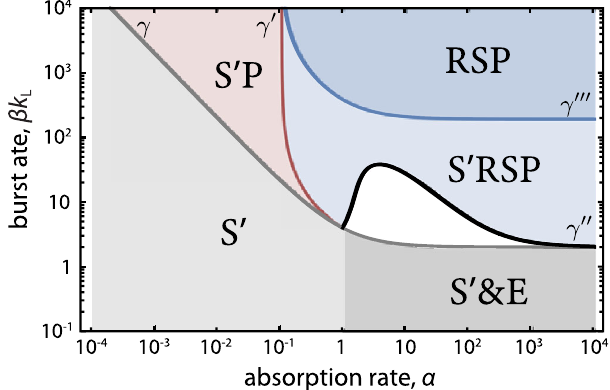
Fig. 5 Phase diagram of the CRISPR spacer loss model. The resistant phenotype R generates the loss-of-spacer phenotype S which bears the cost of resistance without the bene fi t of immunity. S 0 corresponds to a phage- sensitive phenotype of a strain that lacks CRISPR and does not pay the cost of resistance. The resistant phase contains two regions, S 0 RSP and RSP, separated by the curve γ ‴ across which the system undergoes a transcritical bifurcation that eliminates S 0 from the population. Coexistence of S 0 with RSP indicates that S 0 bene fi ts from the CRISPR system expressed by R without paying the cost. All the rates are in units of per cell division time (1/div). Parameter values are s = 10 − 3 , n r = 1, d 0 ¼ 1, b = 0.9, k L = 1, K m =